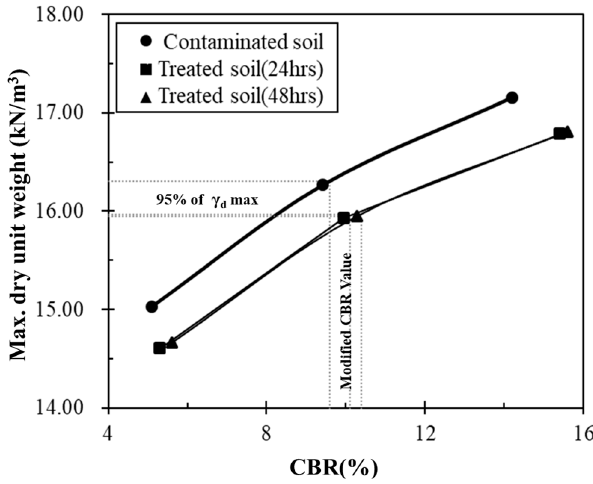
Figure 11. Comparison of secant shear modulus at σ = 147 kPa.